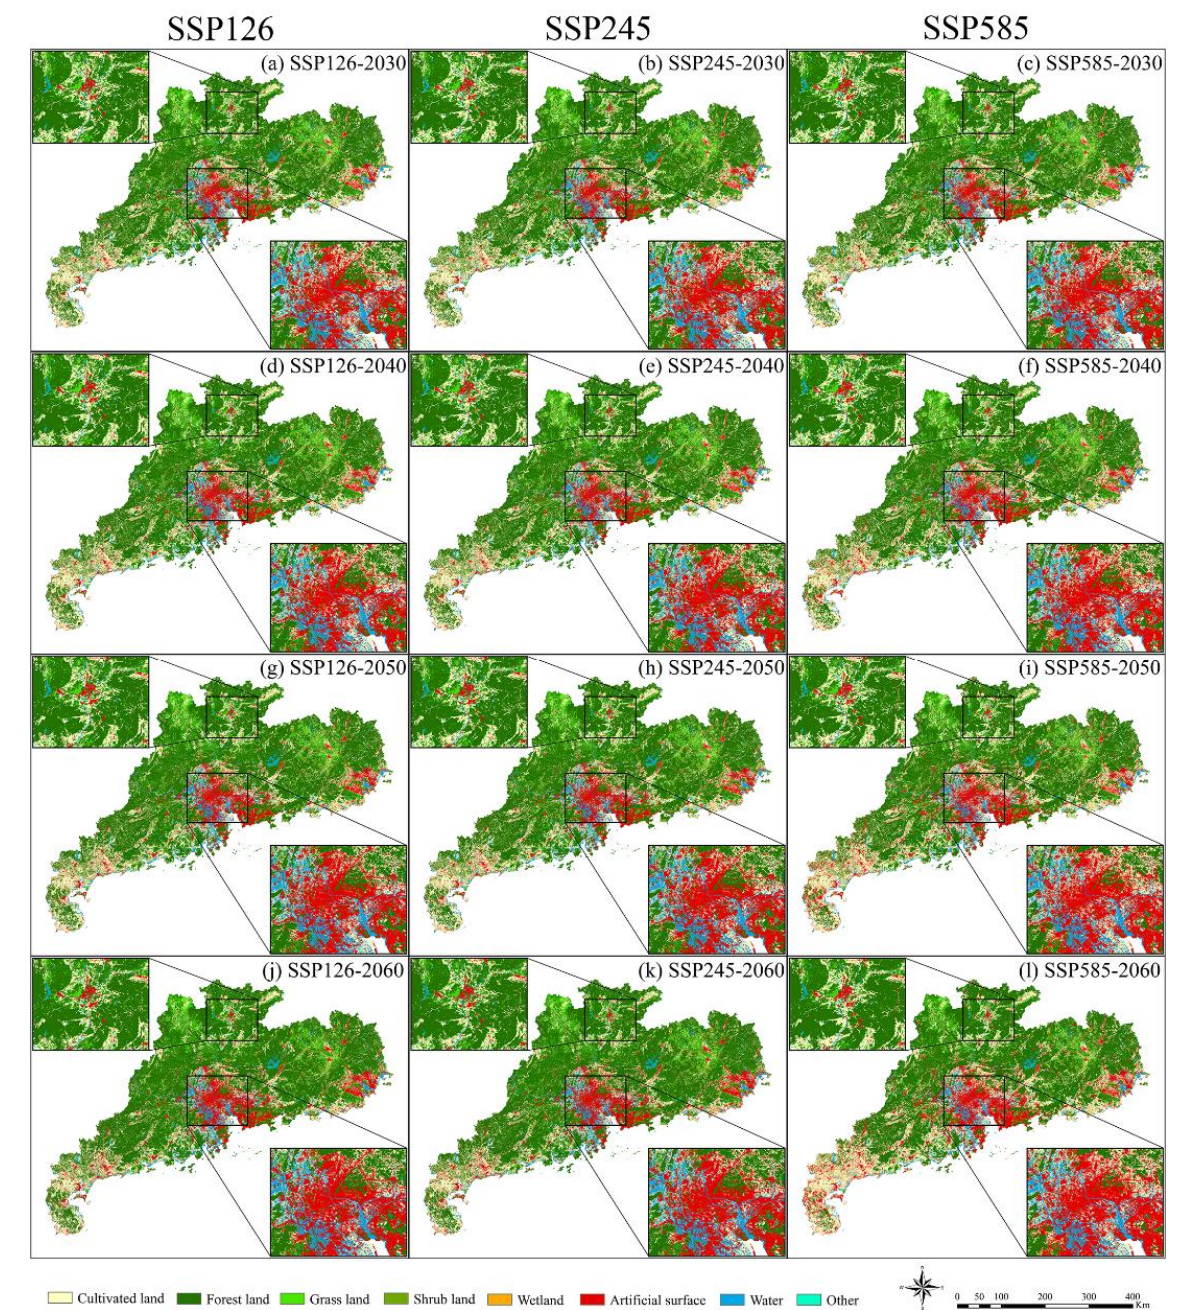
Figure 6. Simulation results of LUCC under different scenarios. Table 3. Statistics of each land use type under different scenarios (km 2